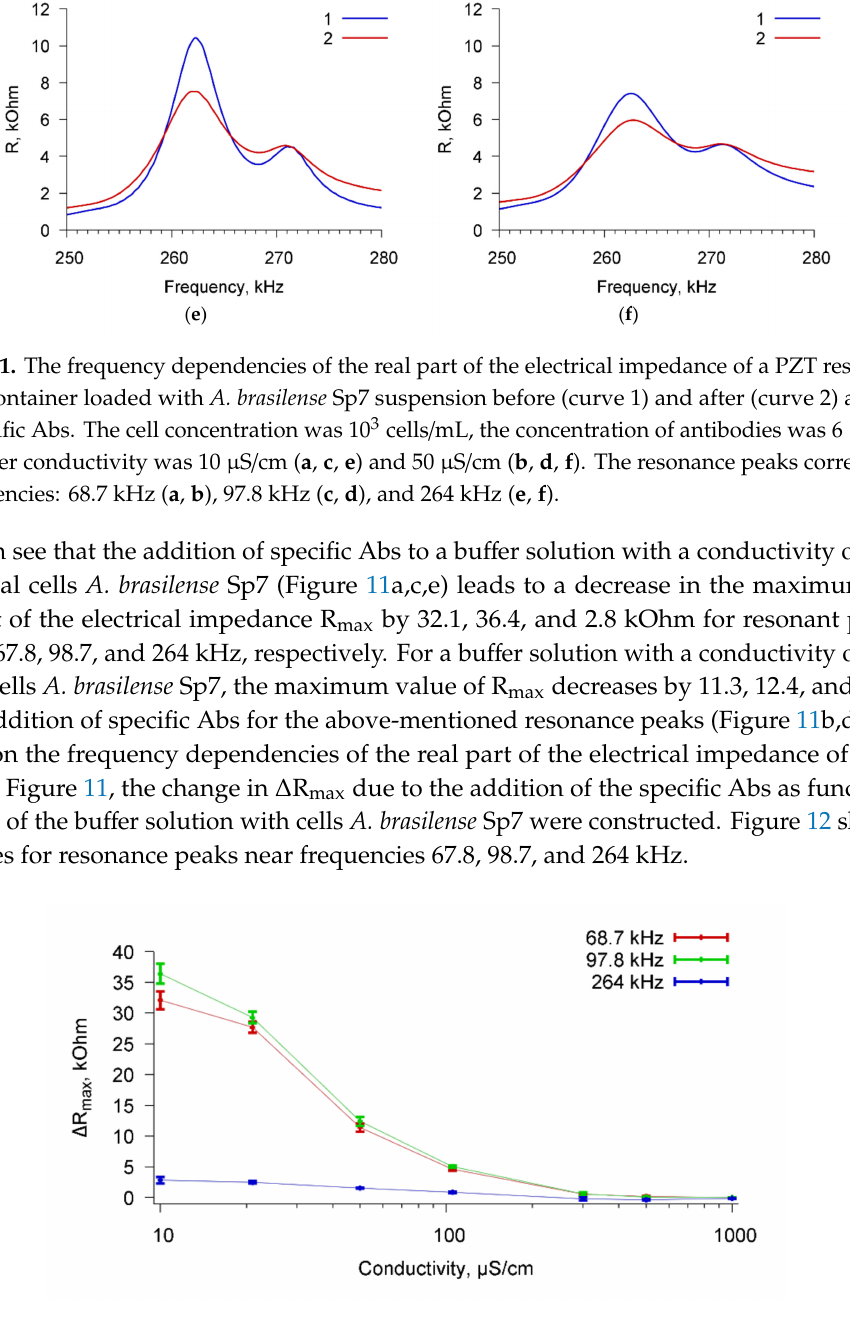
Figure 12. Dependencies of ∆ R max on the conductivity of the bu ff er solution when specific Abs was added to the bu ff er with the cells A. brasilense Sp7 for resonance peaks near frequencies 67.8, 98.7, and 264